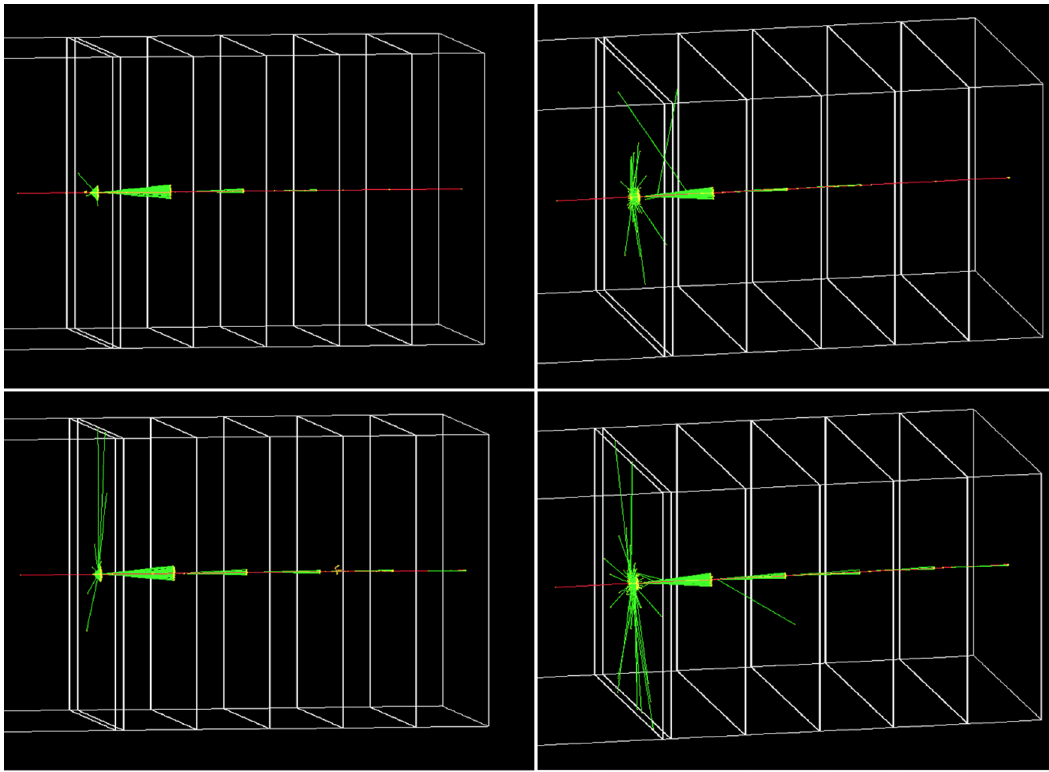
Figure 3. Visualized Geant4 simulations: (i) Cherenkov radiation only (left column), (ii) Cherenkov radiation, scintillation, and transition radiation (right column) when muon momenta are 3.25 (top row) and 10.0 GeV/c (bottom row). Green and red lines represent optical photons and negative muons,